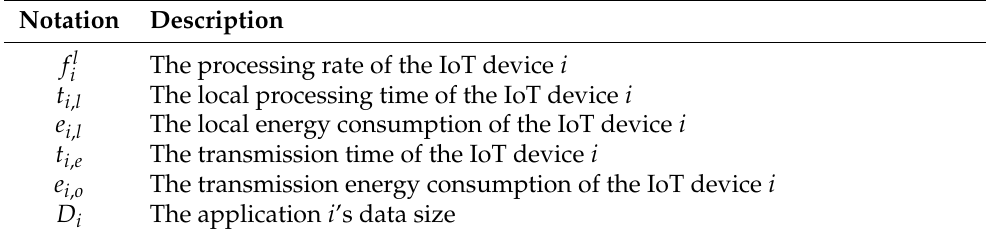
Table 2. A summary of